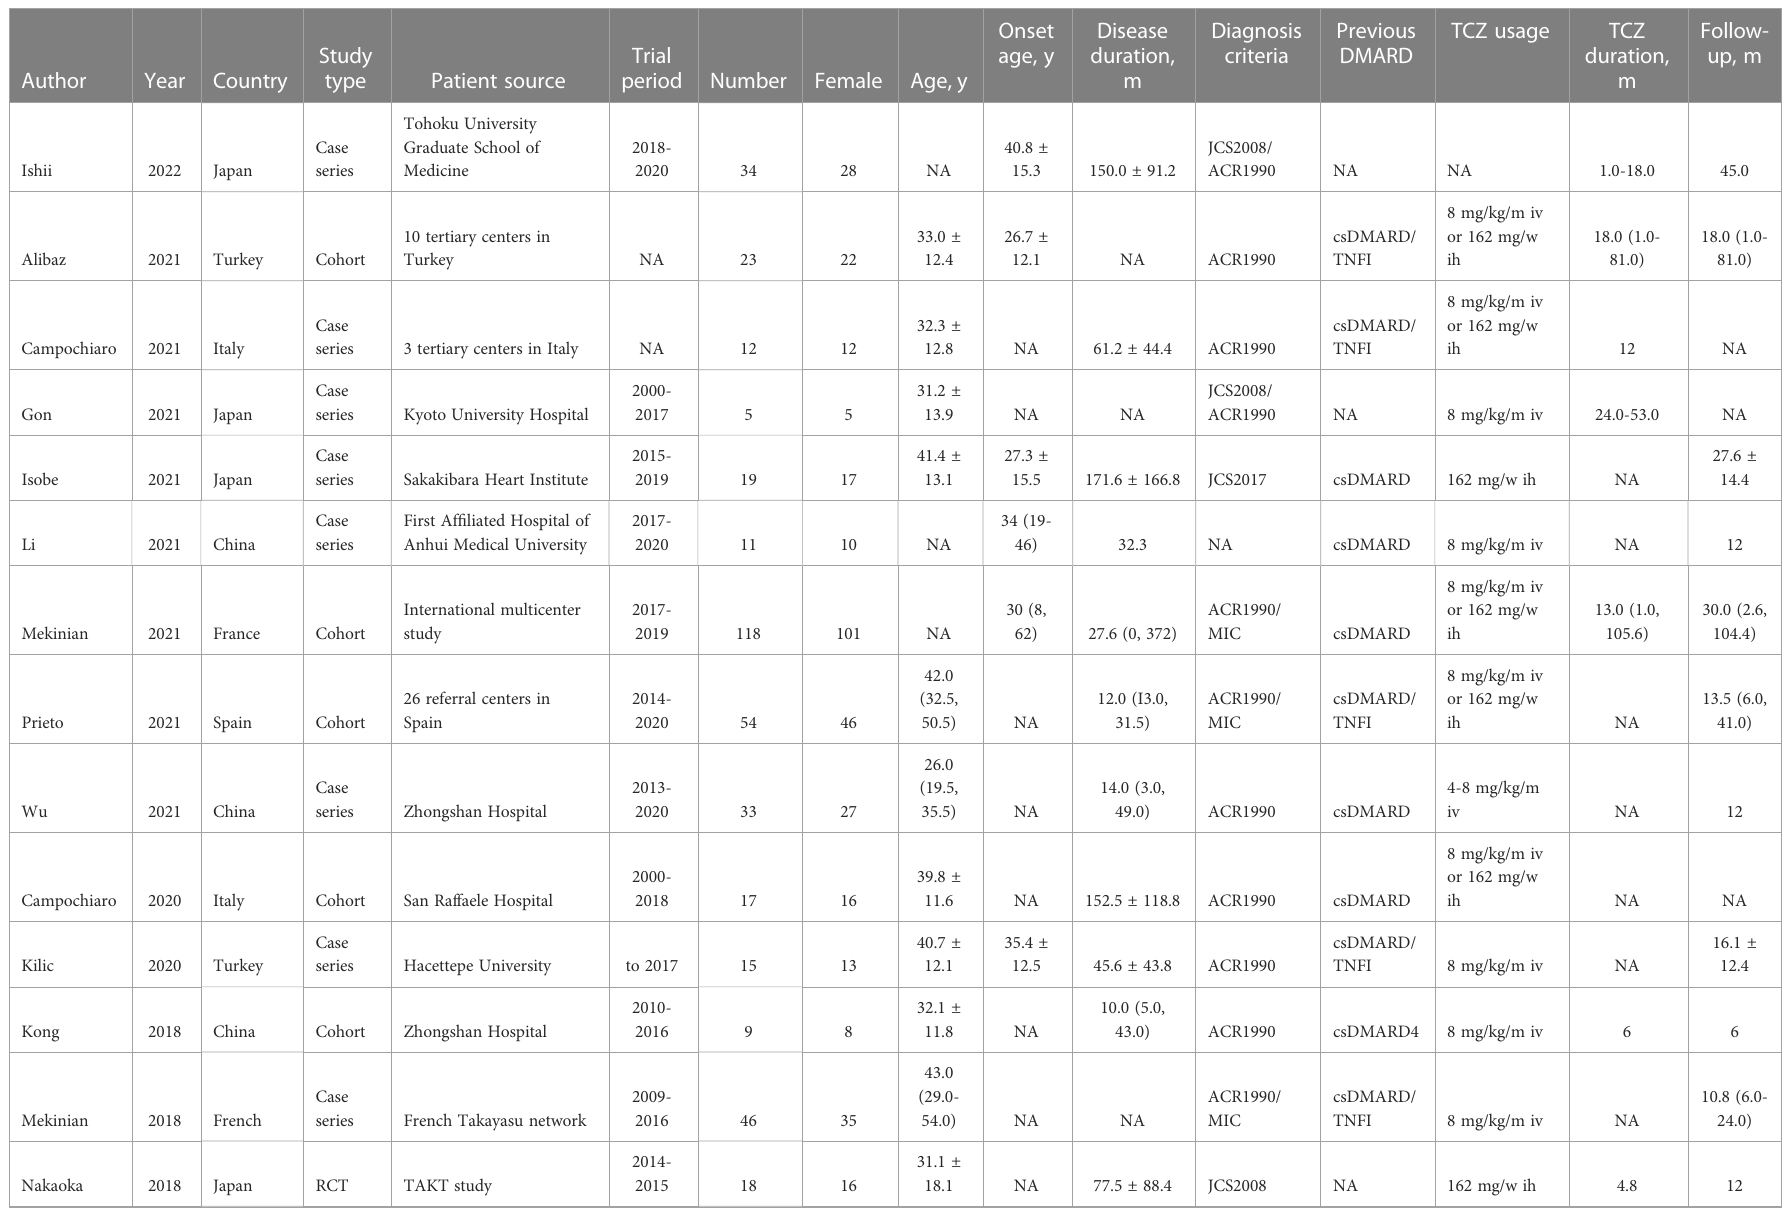
TABLE 1 Detailed characteristics of 19 included studies on tocilizumab in patients with refractory Takayasu arteritis.